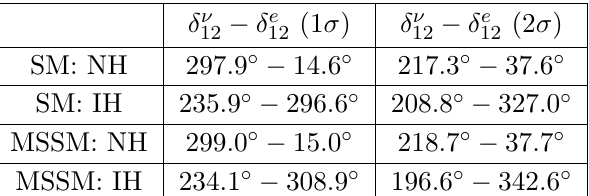
consistent with current experimental values − δ e 12 12